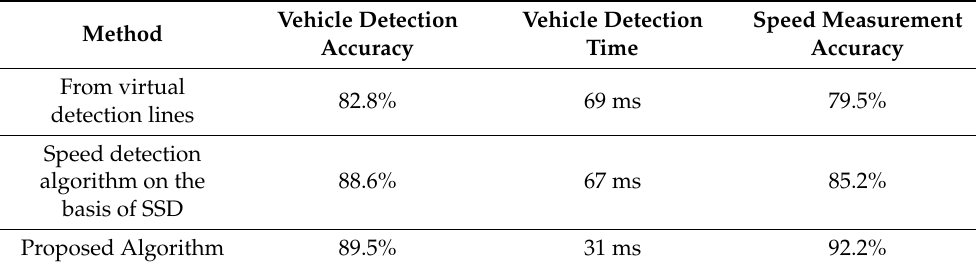
Table 4. Sunny test results.